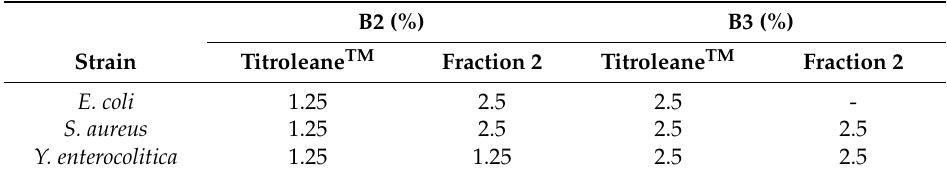
Table 3. Minimal inhibitory concentrations (MICs) of two fractions of Tea Tree oil. Titroleane ™ and Fraction 2 are complementary fractions of standard Tea Tree oil. Both fractions were compared for their MIC activities on three representative bacterial